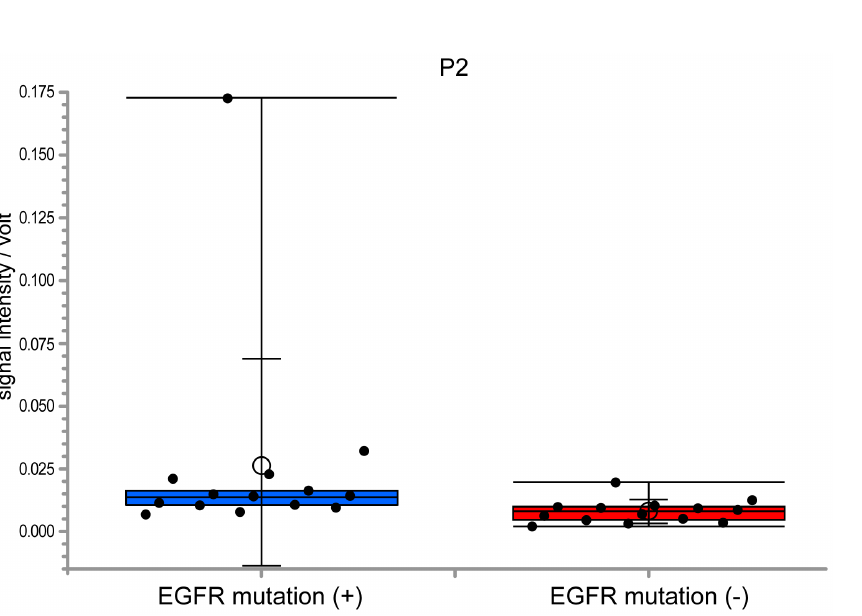
Fig. 4. Box-and-whisker plots showing the IMS signal intensity of peak-2 in adenocarcinoma patients positive and negative for EGFR. Fourteen patients with EGFR mutation displayed a significantly higher n- Dodecane peak with a sensitivity of 85.7% and a specificity of 78.6% (p , 0.01) than in 14 adenocarcinoma patients without the EGFR